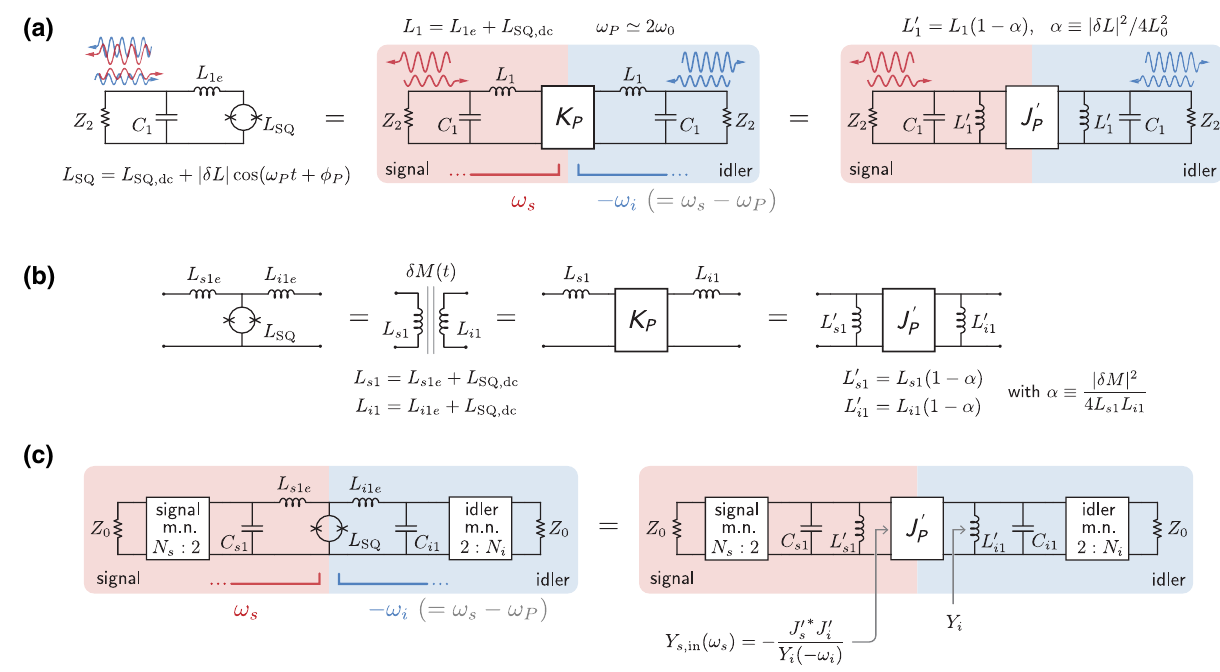
FIG. 24. (a) Transformation of single-pole degenerate Josephson parametric amplifier (left) to a two-port (signal and idler) series parametric inverter representation ( K P , middle), and a shunt parametric inverter representation ( J (cid:12) parametrically modulated inductor tee and modulated mutual inductance circuits, and their K - and J -inverter counterparts. The inverter formulae are given in Fig. 9. (c) Example multipole matching strategy for a nondegenerate parametric amplifier using a parametric J inverter. The tee-equivalent J inverter transforms the SQUID-embedded double-resonator circuit into effective parallel- LC sections of multipole signal and idler matching networks (m.n. in the figure). The input admittance looking into the inverter from the signal circuit Y s ,in (ω s ) is the nondegenerate equivalent to the pumpistor model admittance [49] since Y ∗